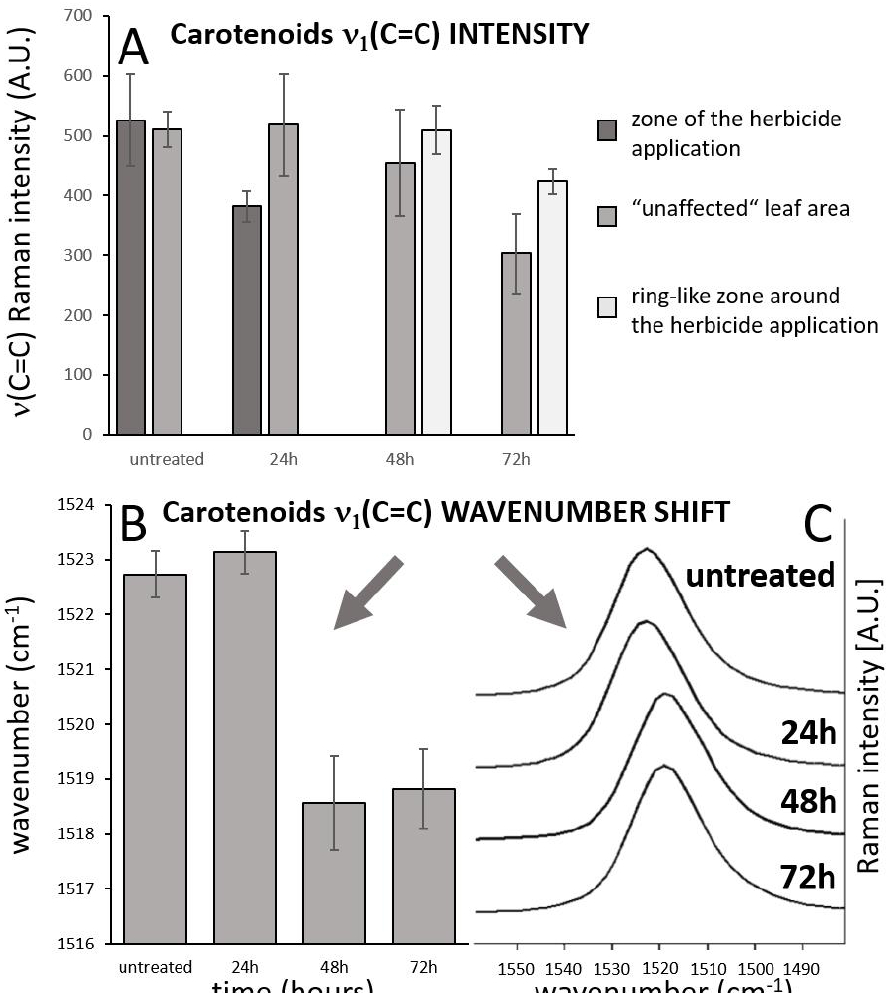
Figure 4. Analysis of temporal changes of the carotenoid ν 1 (C=C) band intensity in the three different zones of the leaf. ( A ). Wavenumber shift of the carotenoid ν 1 (C=C) band with time ( B , C ), spectral data come from imaging datasets and represent mean of 5 randomly selected point spectra from the leaf area that is out of the zone of herbicide application and out of the zone of local carotenoid signal enhancement. Error bars represent standard deviations.